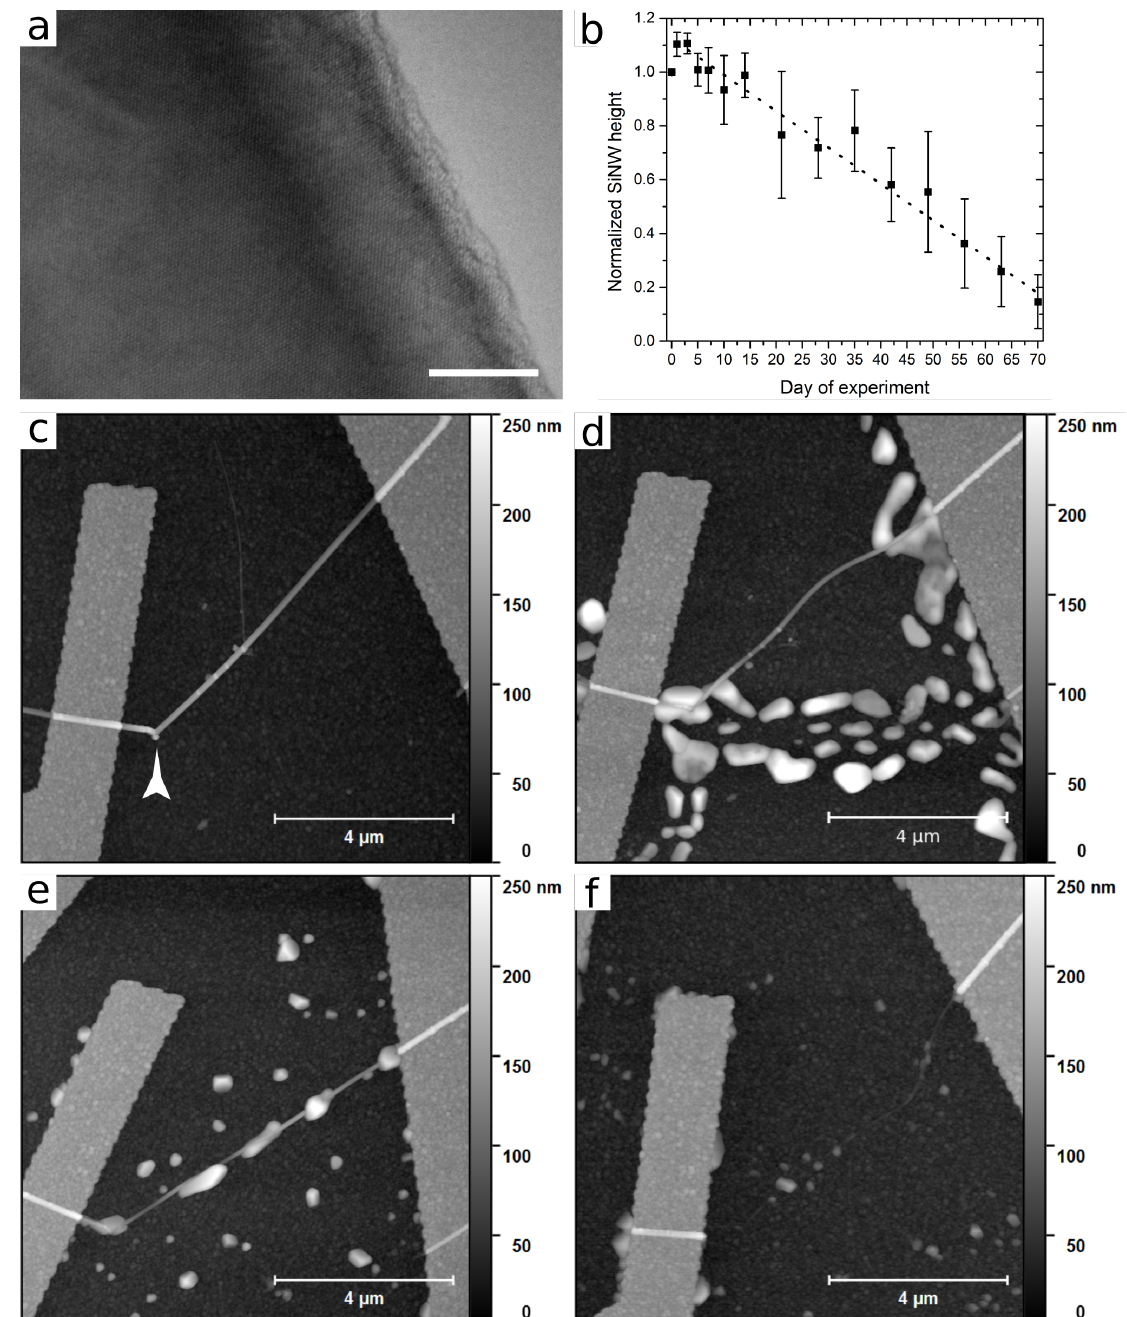
Figure 2. ( a ) TEM analysis of a SiNW covered with a native oxide layer prior to immersion in PBS. Scale bar 10 nm. ( b ) Decrease of SiNW height (corresponding to the diameter) as measured with AFM over time during immersion in PBS at 37 ◦ C. The error bars denote the standard deviation and the dotted line represents a linear fit of the data. ( c – f ) Height scans of a single SiNW after immersion in PBS at 37 ◦ C for: 3 days ( c ); 14 days ( d ); 35 days ( e ); and 63 days ( f ) as measured with AFM. The p–n junction encoded as a kink is marked with an arrow in sub-figure ( c